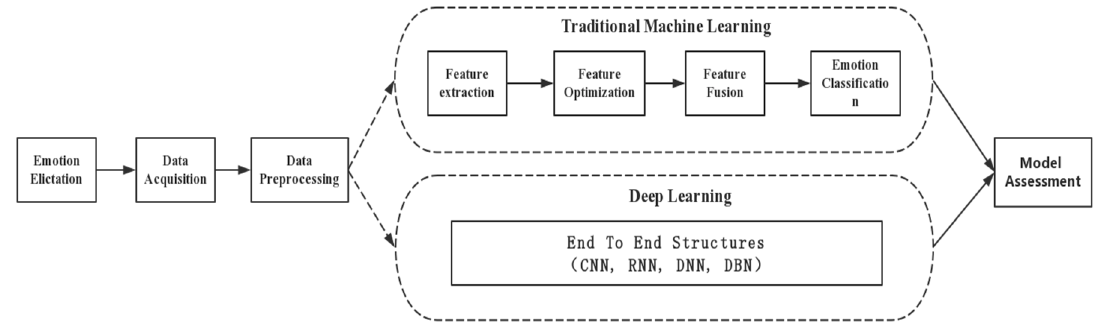
Figure 10. Emotion recognition process using physiological signals under target emotion stimulation.